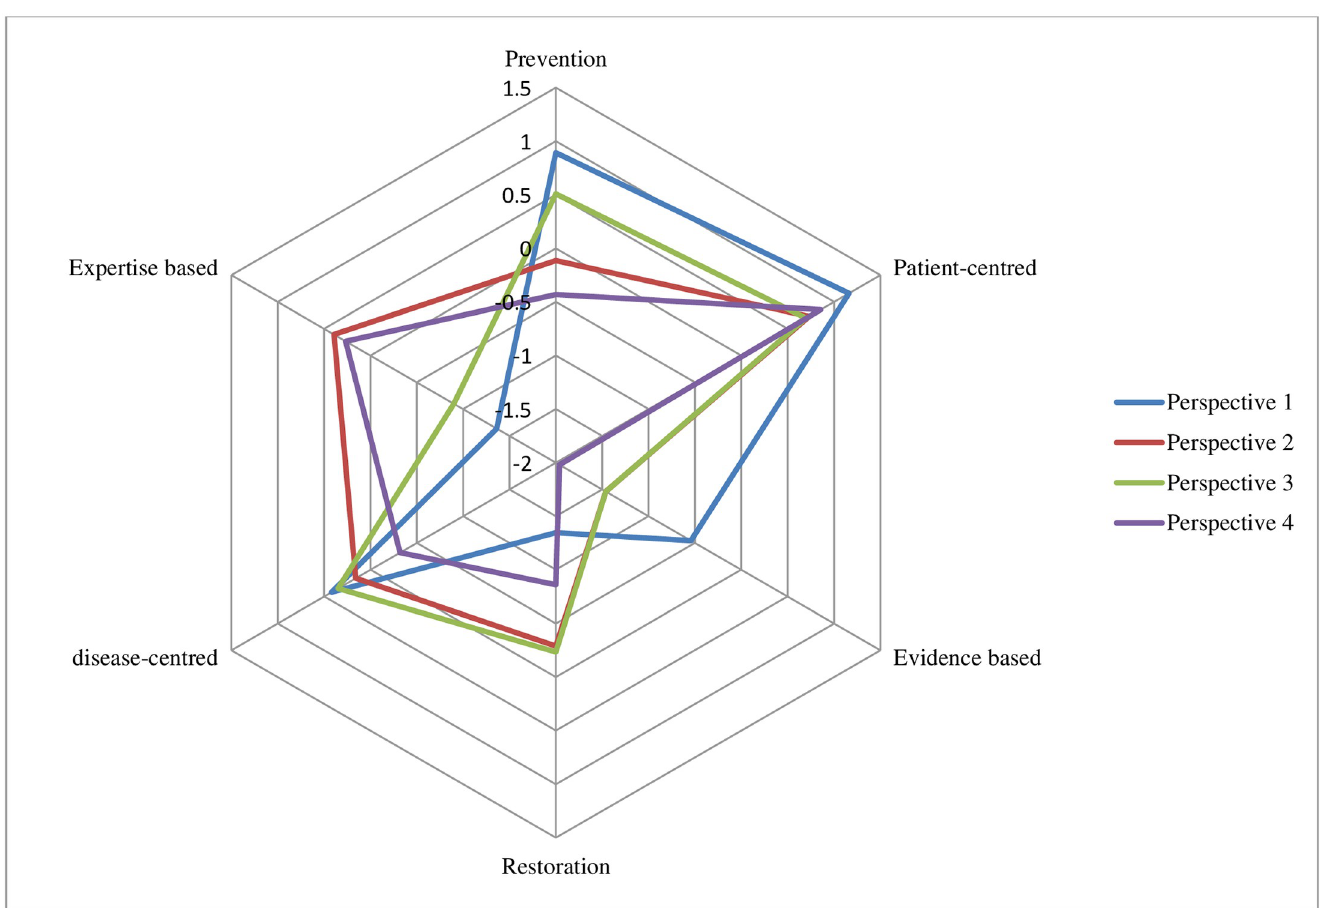
Fig 6. Mean Z-score Q-statements visualized amongst the domains: Prevention-restoration, patient- disease-centered and expertise based -evidence based. Mean z-score of Q-statements listed in Table 2 Prevention statements: no. 1, 14, 15 and 20 Restoration statements: no. 9, 19 and 28 Patient-centered statements: no. 10, 13, 17, 21, 29, 31, 37 and 38 disease-centered statements: no. 2, 22 and 47.Evidence-based statement: no. 50 Expertise-based statement: no.